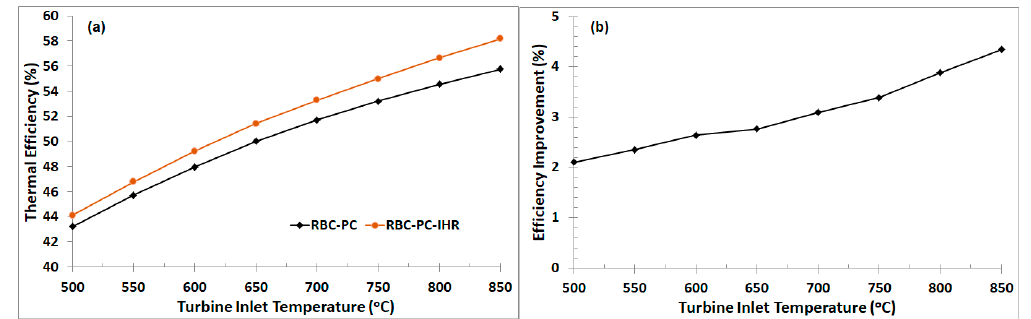
Figure 7. ( a ) The thermal efficiencies of RBC-PC-IHR and RBC-PC plotted versus turbine inlet temperatures from 500 °C to 850 °C. ( b ) The improvement in thermal efficiency from RBC-PC-IHR compared to RBC-PC in percentage points.